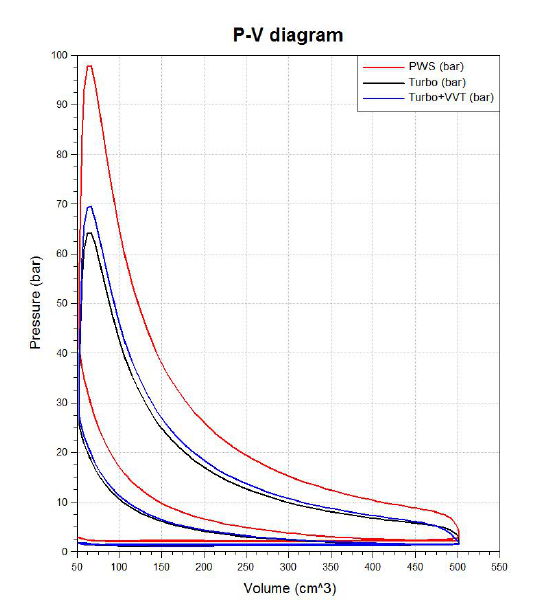
Figure 9. P-V diagram of the 3 supercharging solutions.